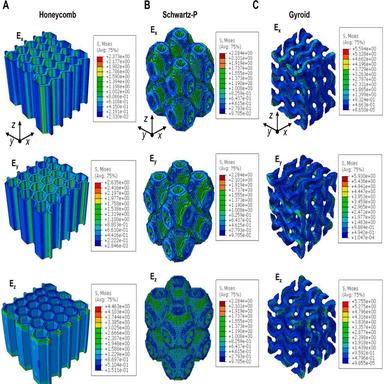
Von Mises stress distribution of soft lattice scaffolds with different geometry derived from FE models under compression along the x, y, and z directions.